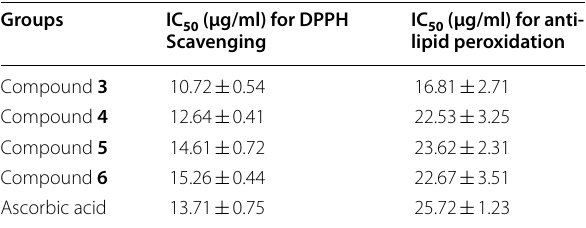
Table 3 Showing antioxidant activities of the newly synthesized compounds